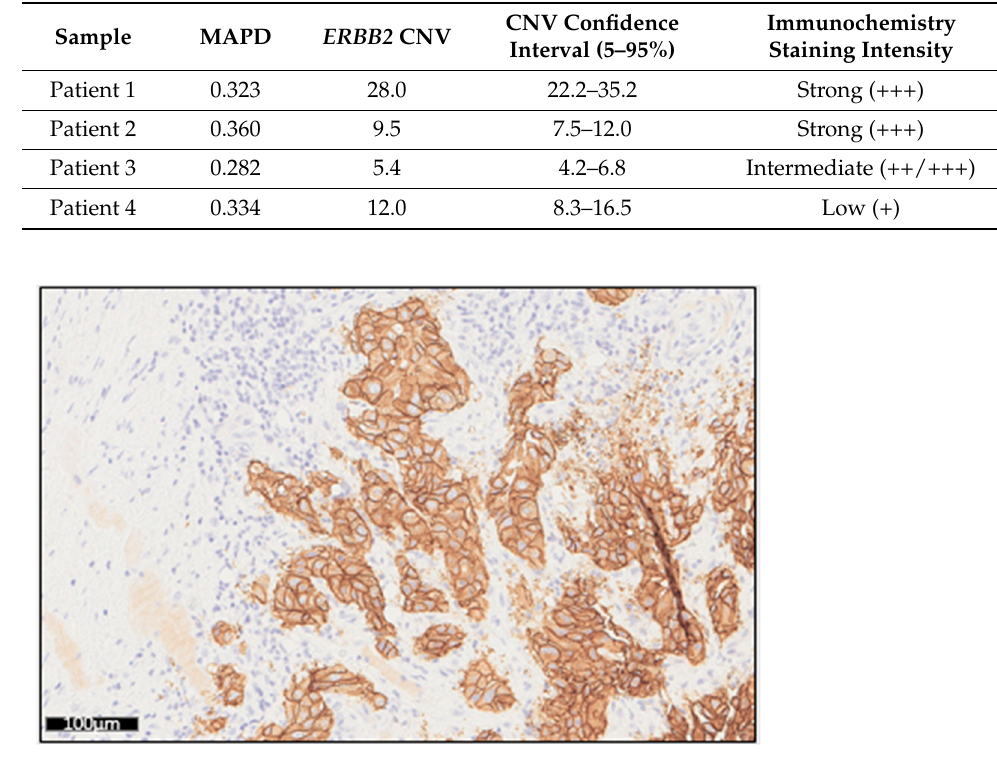
Figure 5. Overexpression of ERRB2 in a case of gene amplification. Immunocytochemistry analysis of ERRB2 protein expression in a lung adenocarcinoma (Patient 1).